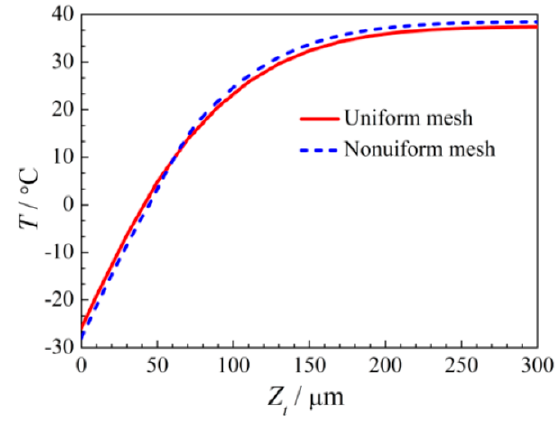
Figure 6. Axial temperature in skin tissue with uniform and nonuniform mesh system.